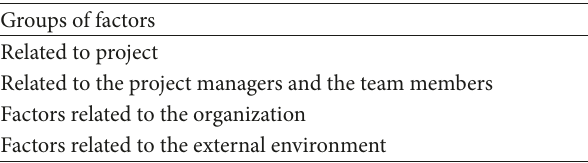
Table 1: Belassi and Tukel taxonomy. Table 2: Failure causes considered in the